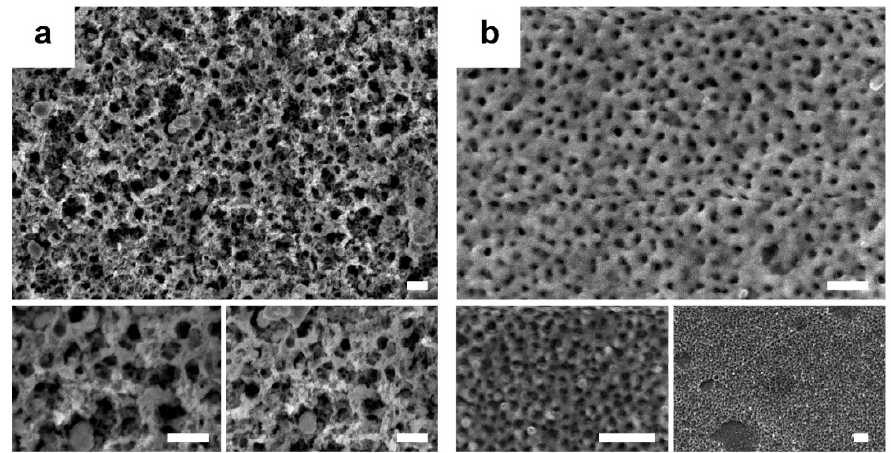
Figure 4. FE-SEM micrographs at different magnifications of the deposits obtained using Ni (Bath 3) solution on ( a ) FTO-coated glass and ( b ) Si/Ti/Au substrates at − 1.3 V (vs. Ag|AgCl) after circulating 7.5 C cm − 2 . Scale bar: 300 nm.